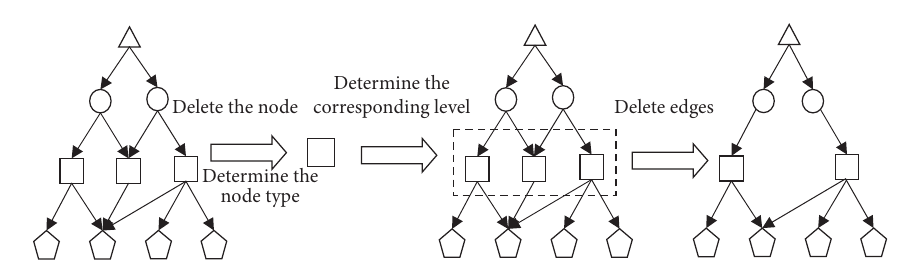
Figure 4: Delete supply chain network